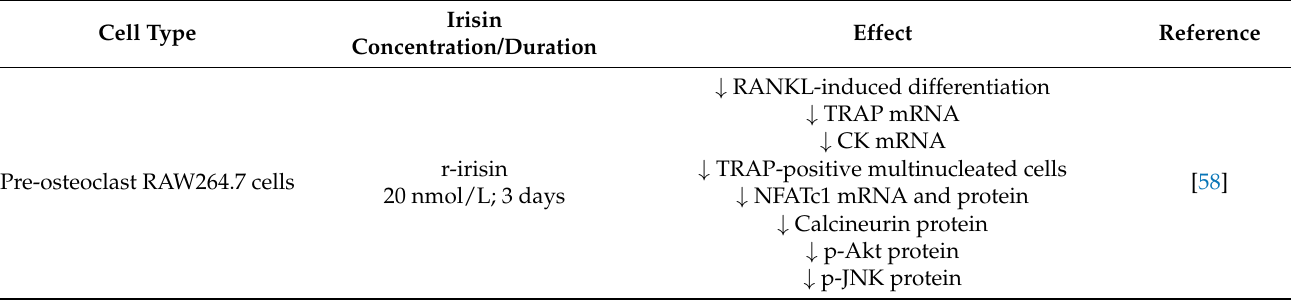
Table 2. Role of Irisin on Osteoclasts: in vitro